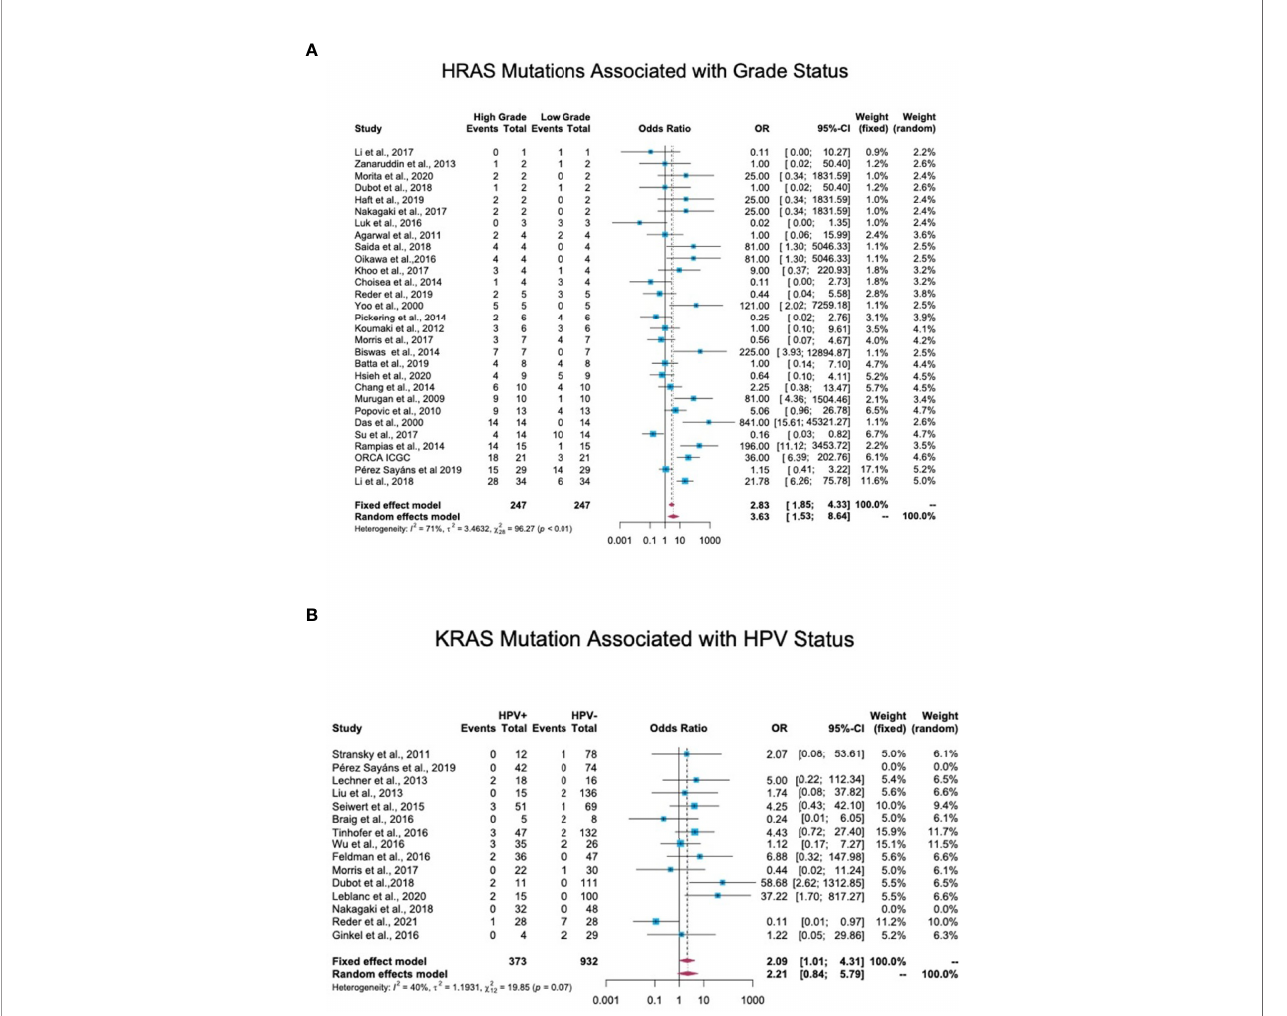
FIGURE 6 | Association between RAS mutations and patients ’ clinical features. (A) Association between HRAS mutations and tumor grade. In total, 44 studies reported details regarding tumor stage or grade and mutation status. Stage/grade 1 and 2 tumors were categorized as low-grade, while stage/grade 3 and 4 tumors were categorized as high-grade. An OR analysis exhibited a signi fi cant association between HRAS mutation status and advanced stage (OR = 3.63; 95% CI, 1.53- 8.64). (B) Association between KRAS mutations and human papillomavirus (HPV) infection status. In total, 17 studies reported the detection of RAS mutations in both HPV-positive and HPV-negative patients. An OR analysis revealed a signi fi cant association between KRAS mutation status and HPV infection (OR = 2.09; 95% CI, 1.01-4.31). CI, Con fi dence interval; I 2 , Inconsistency index; OR, Odds